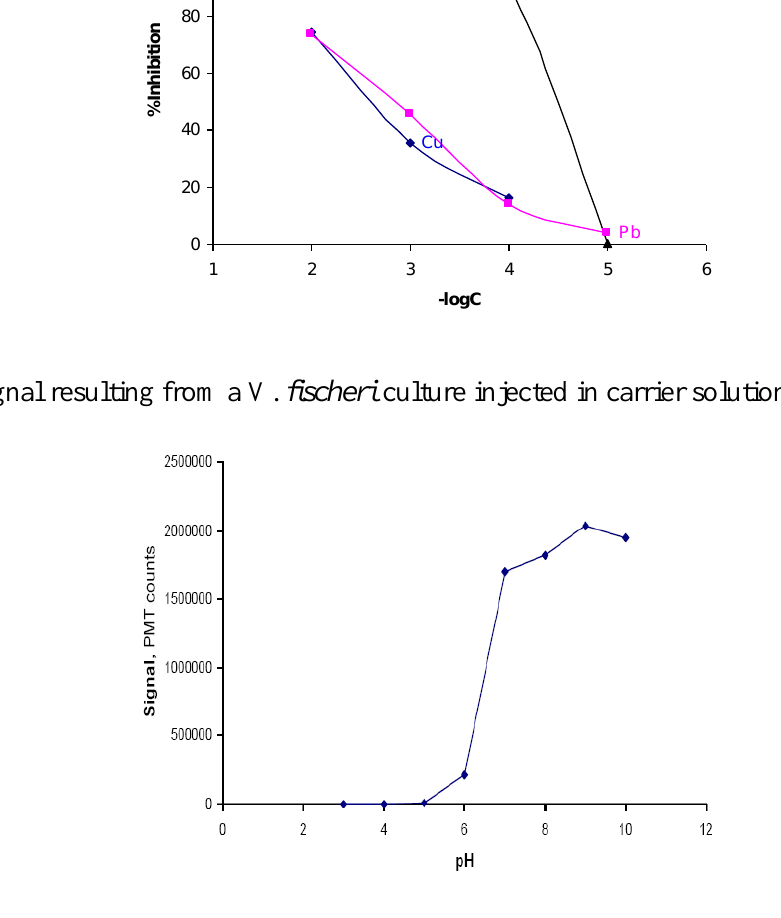
Pb 2+ and Cu 2+ . It is ,